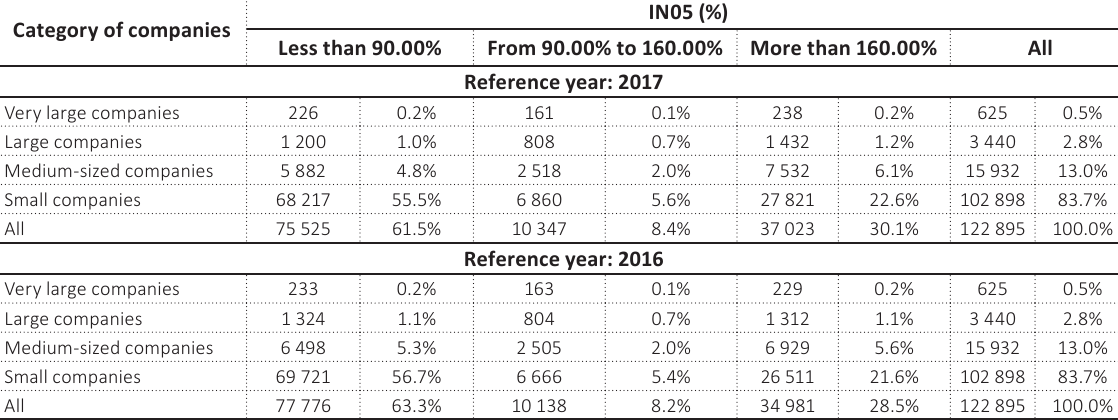
Table 4 (cont.). IN05 values of the total of active Hungarian companies grouped by size and